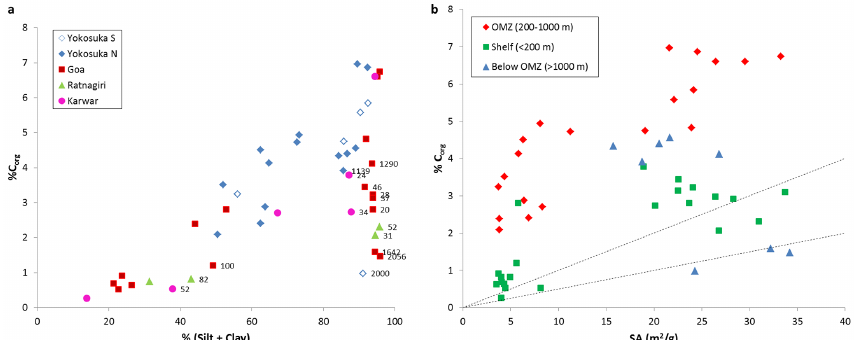
Figure 8. (a) A plot of organic C content (%C org ) against percentage (by volume) of silt and clay (%(Silt + Clay)) in surficial shelf and slope sediments. Marker labels show station depths for selected sites. (b) A plot of %C org against estimated specific surface area (SA, m 2 g − 1 ) for sediments from sites within, above and below the OMZ, here defined as sites at depths <200, 200–1000 and >1000m, respectively. Dashed lines indicate the approximate 0.5–1.0mgCm − 2 range of organic C loadings commonly observed on normoxic margins (Hedges and Keil, 1995). Surface area values are estimated from a relationship observed for surface sediments from the Oman and Pakistan margins; SA = 251.42 × − 0 . 761 , where × is mean grain size